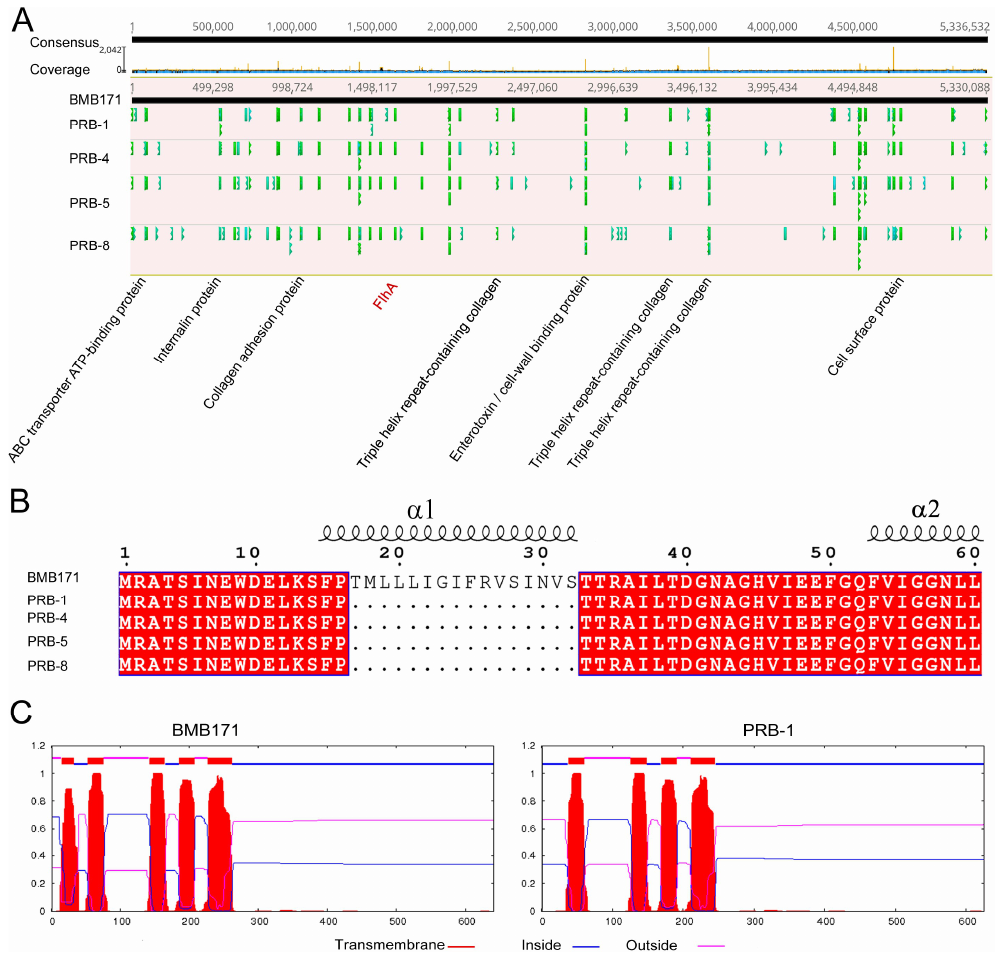
Figure 4. Analysis of the mutations of the phage-resistant bacterial mutants. ( A ) The mutant sites in four phage-resistant bacterial mutants. The functions and locations of the cell surface proteins that mutated in all the four mutants are indicated. ( B ) Alignment of the protein FlhA from the strains BMB171 and four phage-resistant mutants. The secondary structures of the protein are indicated. ( C ) Transmembrane domain of protein FlhA from strain BMB171 and PRB-1.